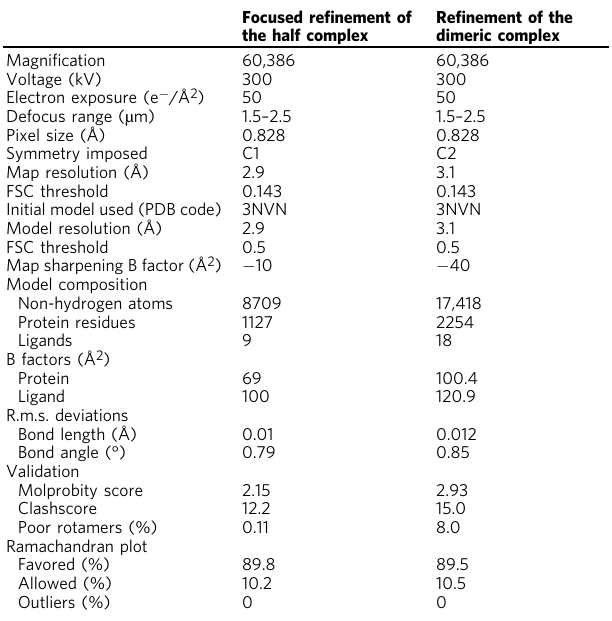
Table 1 Data collection and model re fi nement